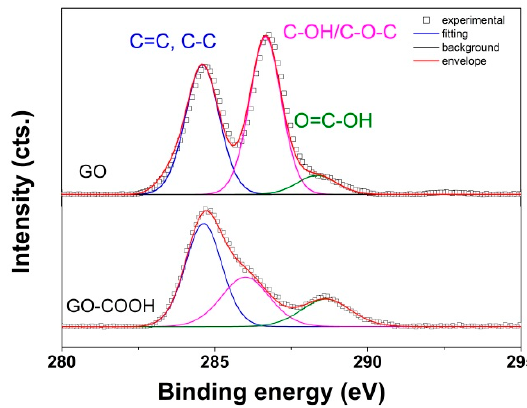
Figure 2. XPS C 1s spectra of GO and GO-COOH.